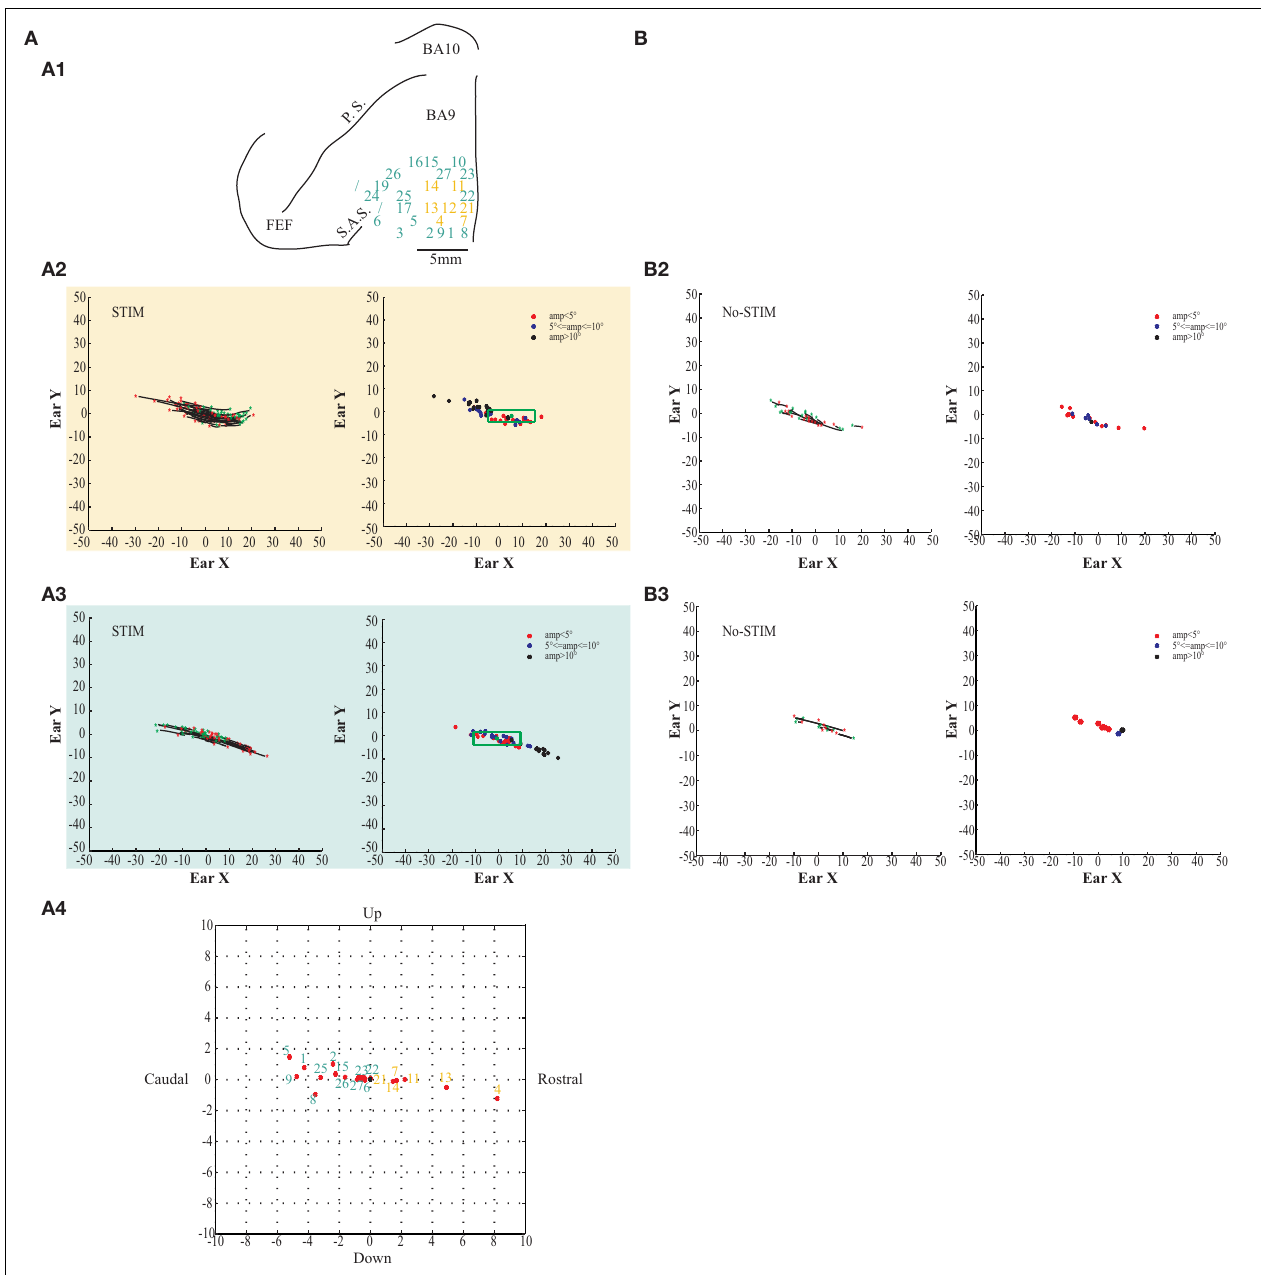
FIGURE 3 | Example of goal-directed ear movements. (A) The figures show data from Monkey S. For further information on the figures the reader should refer to the legend of Figure 2 .